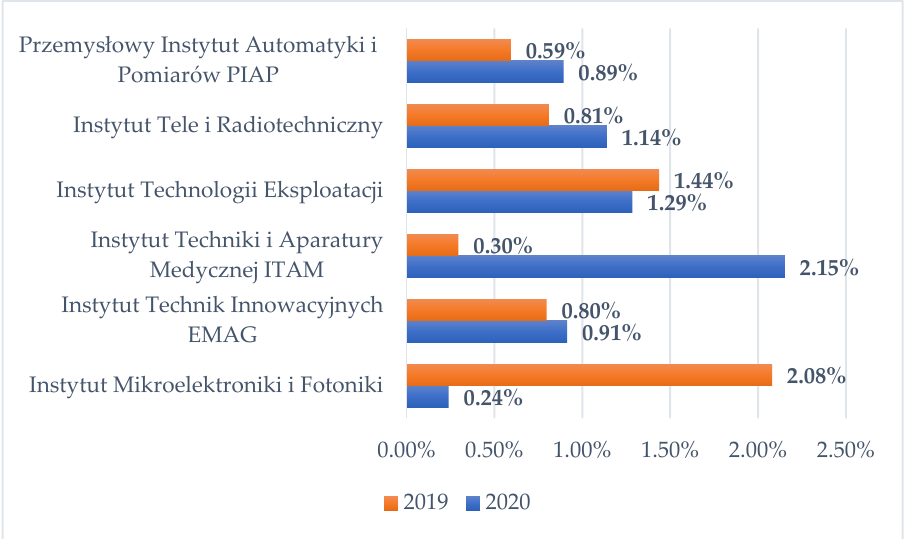
Figure 6. Return on assets (ROA) of researched institutes in 2019–2020 [in %]. Source: [97].